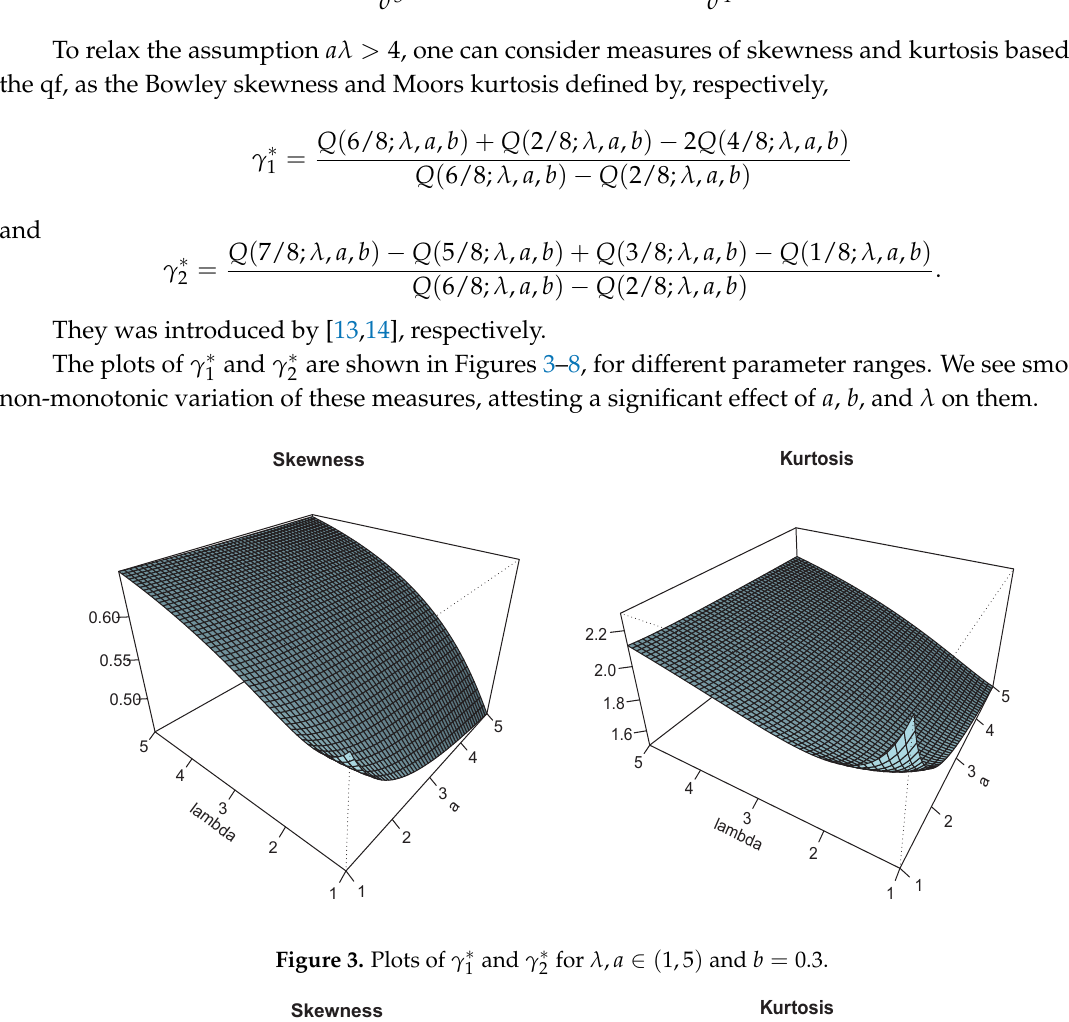
and γ ∗ for λ , a ∈ ( 1,5 ) and b = 0.3. 2 1